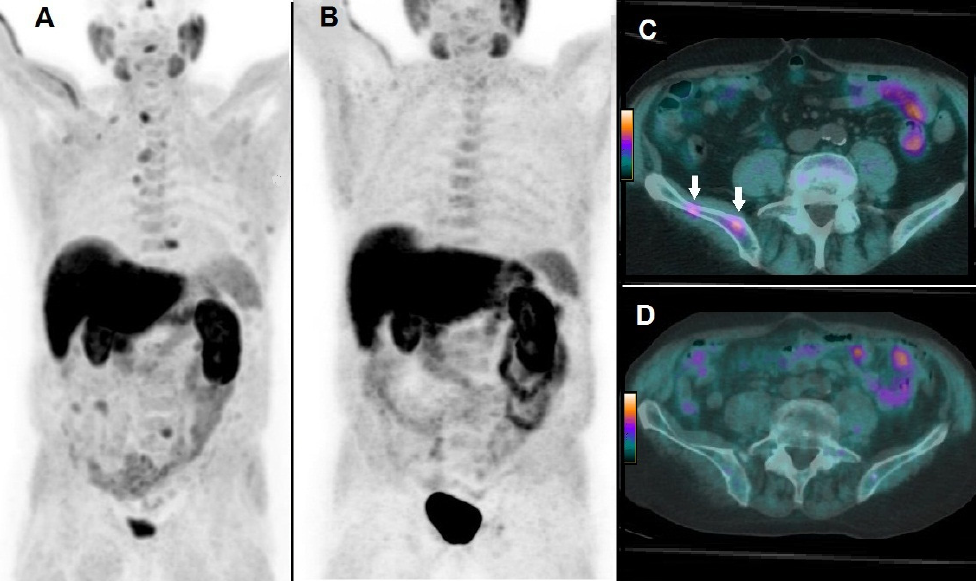
Figure 4. A 74-year-old patient affected by mCRPC, previously treated with androgen deprivation therapy, subsequently submitted to 223 Ra-therapy. At baseline, 18 F-choline PET/CT demonstrated multiple sites of tracer uptake in bones, as evident in Whole Body ( A ) and the following parameters were registered: PSA = 17 ng/mL; number of lesions = 18; TLA = 235.3 g. 18 F-choline PET/CT acquired after 6 cycles of 223 Ra-therapy demonstrated complete metabolic response as depicted by Whole Body ( B ). 18 F-choline PET/CT fused axial images of the pelvis acquired at baseline showed hypermetabolic lesions in the right iliac bone ( C , white arrows), while post-treatment axial slices did not show any pathological sites of tracer uptake ( D ). Post-treatment PSA was 3 ng/mL, OS resulted in 27 months.